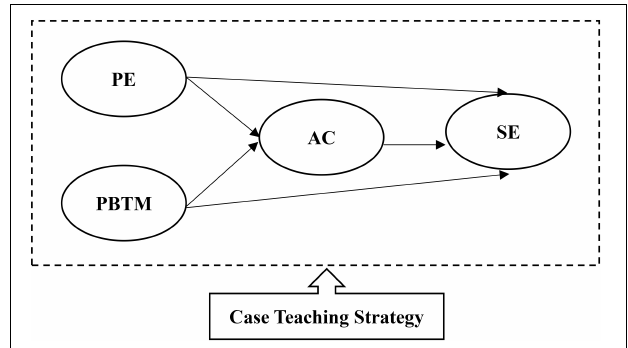
FIGURE 1 | Research